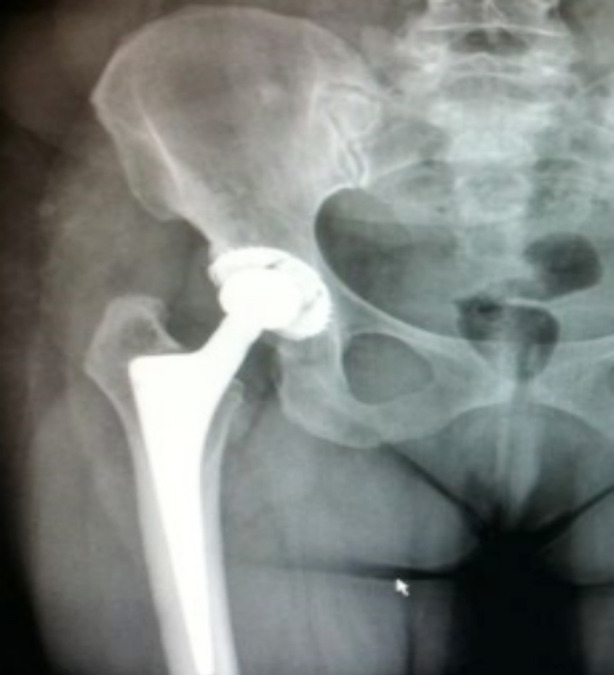
Radiograph of a 64-year-old female patient, showing the 15-year-old implant in THA. The patient had a Harris Hip Score of 96.